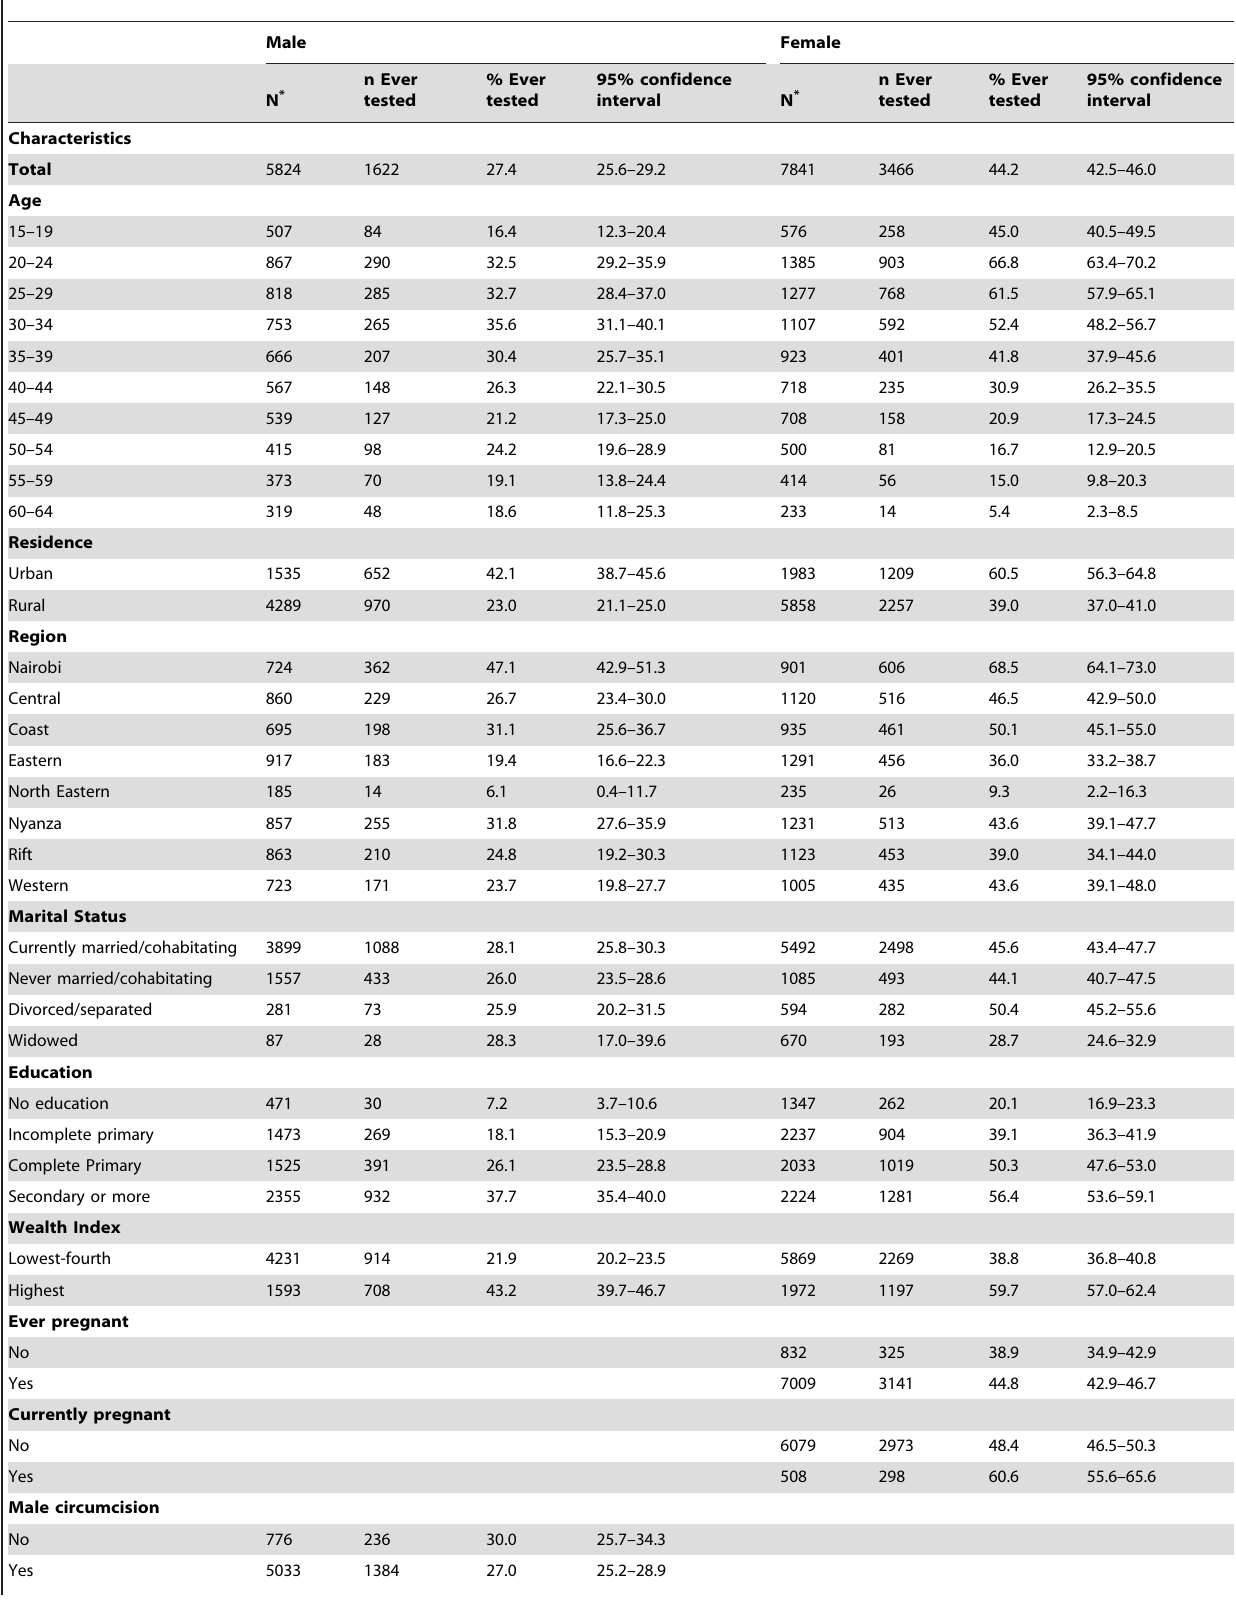
Table 1. Socio-demographic characteristics of persons aged 15–64 years reporting ever HIV testing, by gender, Kenya AIDS Indicator Survey